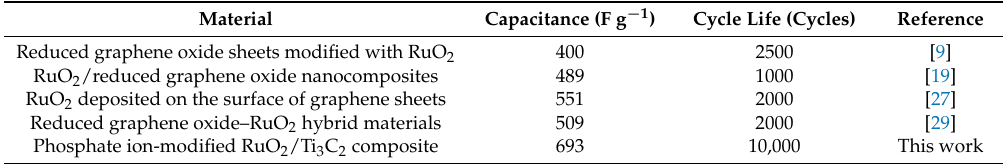
Table 2. Comparison of PRT with other reported RuO 2